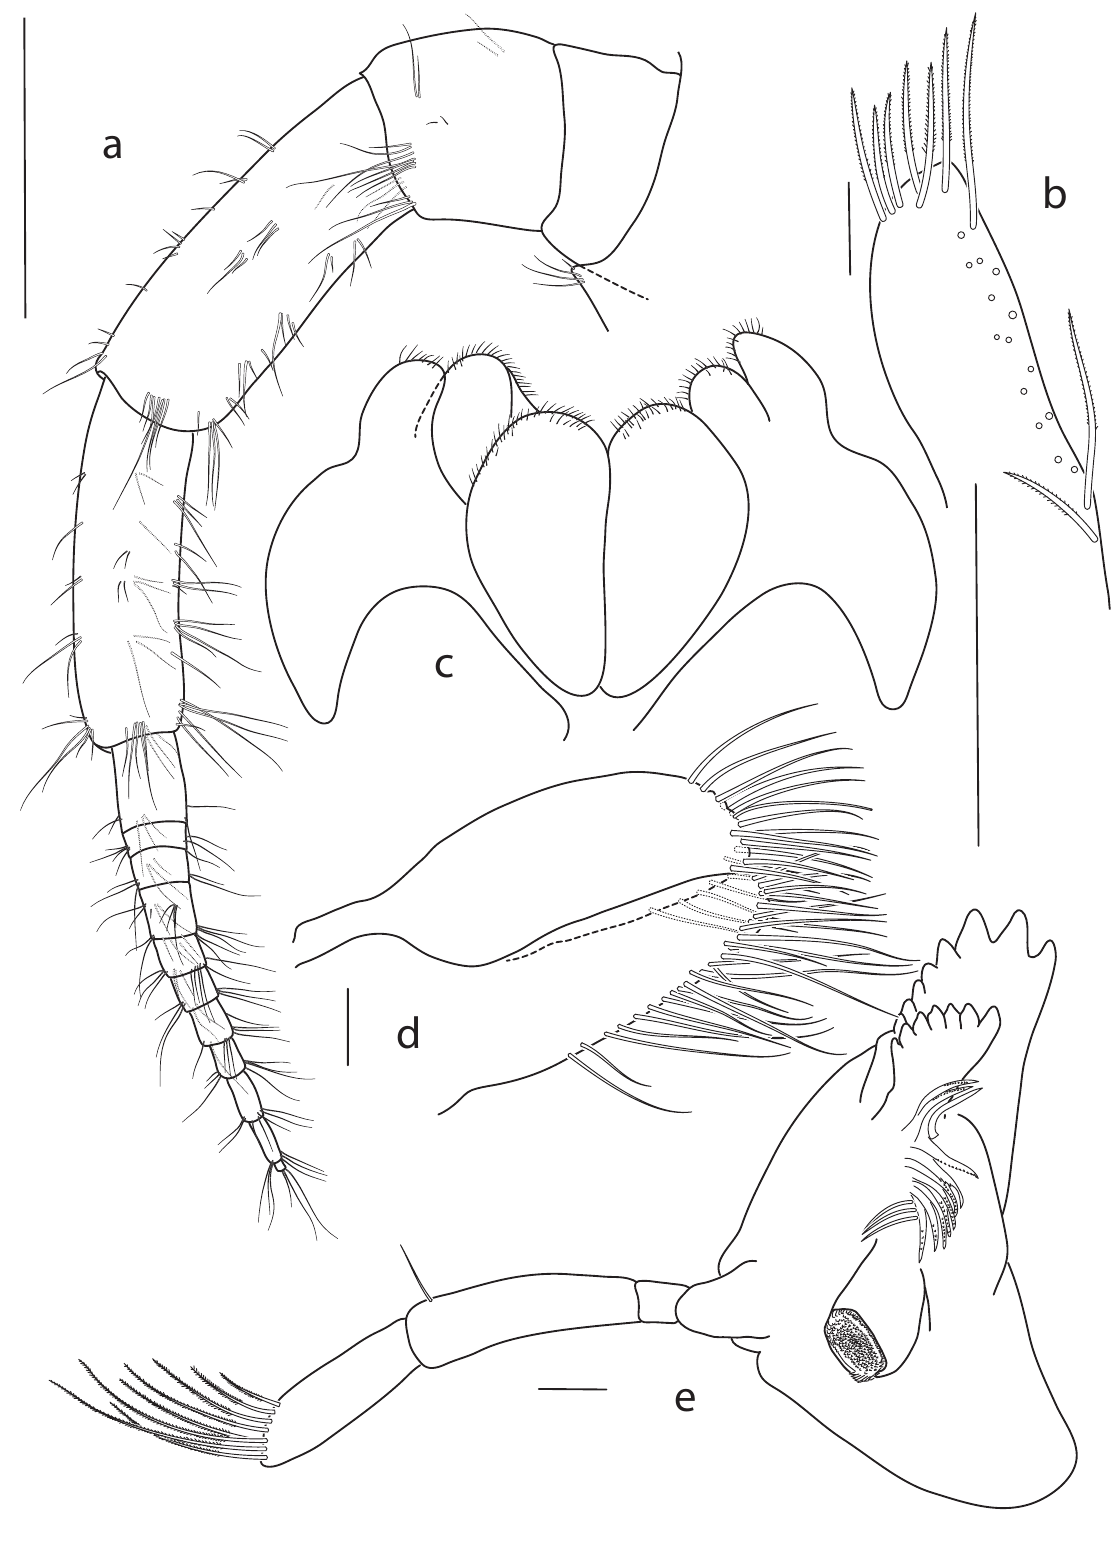
Fig. 2. Sunamphitoe femorata (Krøyer, 1845), ♂, 12 mm (ZMB 34100). a . Antenna 2. b . Inner plate of maxilliped. c . Lower lip. d . Maxilla 2. e . Mandible. Scale bars: a, c = 500 µm; b, d–e = 100